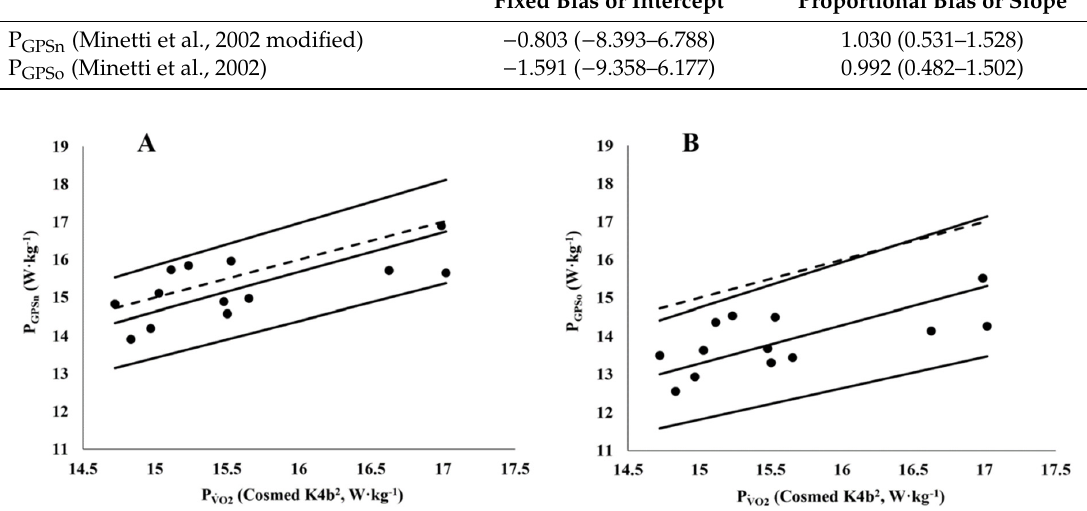
Figure 4. Ordinary least products regression of P GPS values on P (cid:2906)(cid:4662)(cid:2899)